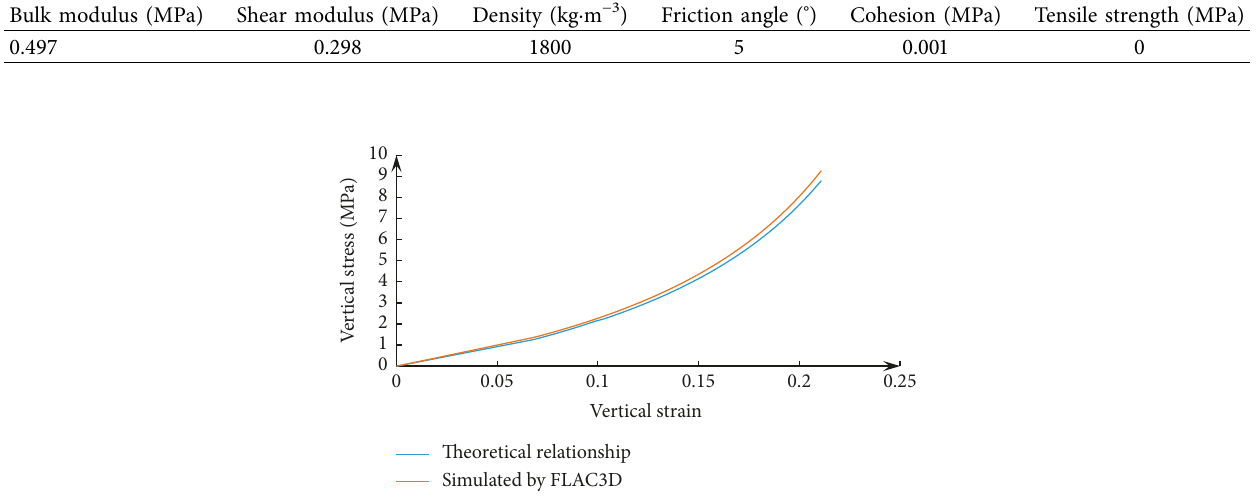
Table 4: Numerical simulation parameters of the gob.